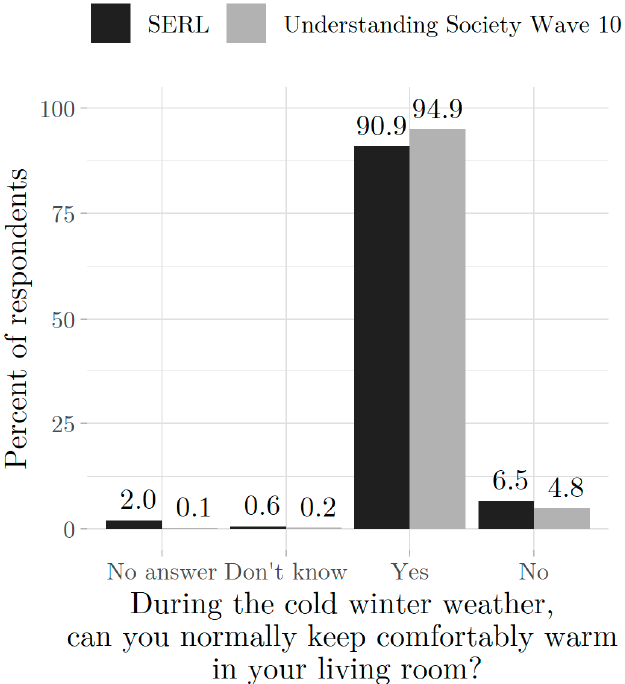
Figure 17. Comparing responses to SERL survey question B7 about being able to keep comfortably warm with a similar question in Understanding Society Wave 10.